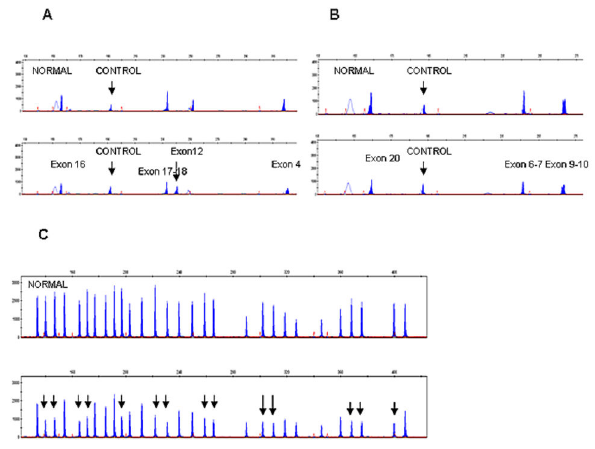
Figure 1. Detection of CLCNKB deletions by the QMPSF and MLPA techniques. QMPSF and MLPA electropherograms for the CLCNKB gene from controls (upper panels) and patients (lower panels). (A) QMPSF half doses for exons 16, 17-18, 12 and 4. The arrow shows the peak for exon 12 with the small deletion c.1192_1203del12 (patient SOR0063). Exon 7 of the HNF1B gene is the internal control. (B) QMPSF half doses for exons 20, 6-7 and 9-10. (C) For MLPA, each peak represents the exons for the CLCNKB gene and 15 control probes. The arrows show half doses for all the CLCNKB exons (patient SOR0011, family SOR0024 and SOR0063).